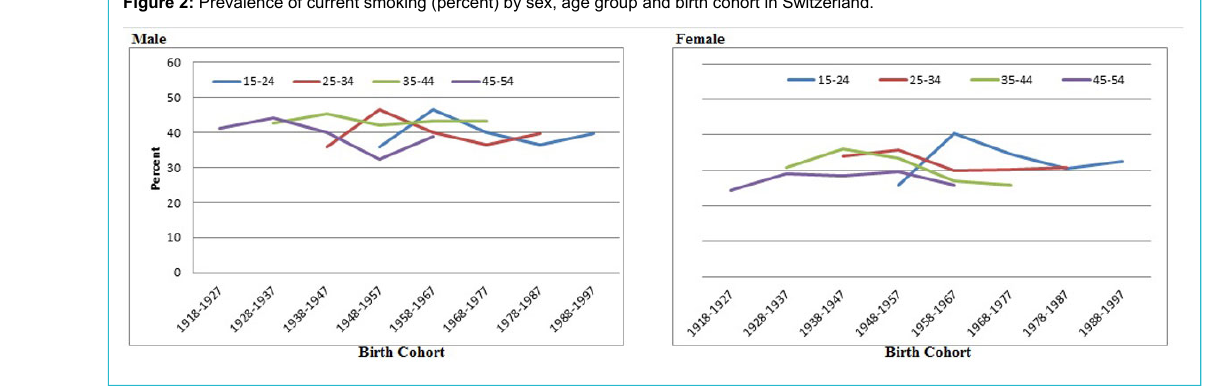
Figure 2: Prevalence of current smoking (percent) by sex, age group and birth cohort in